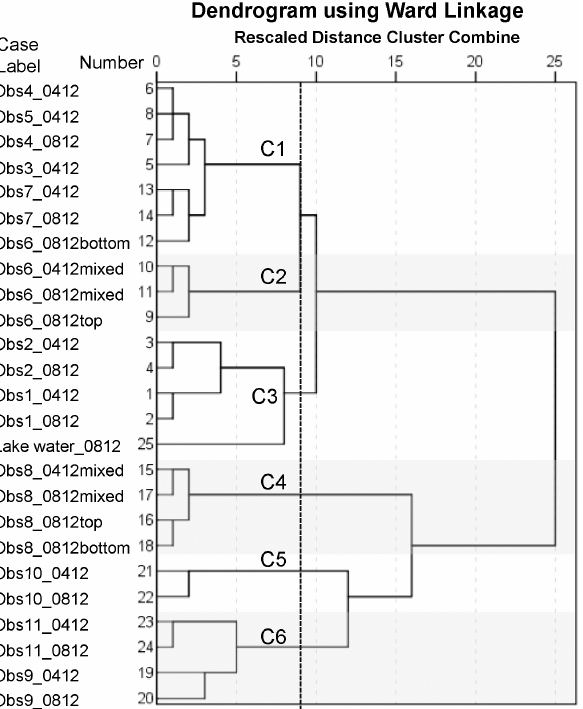
Figure 7. Hierarchical clustering results (dendrogram) of water samples ( n = 25) taken during spring (April) and summer (August)